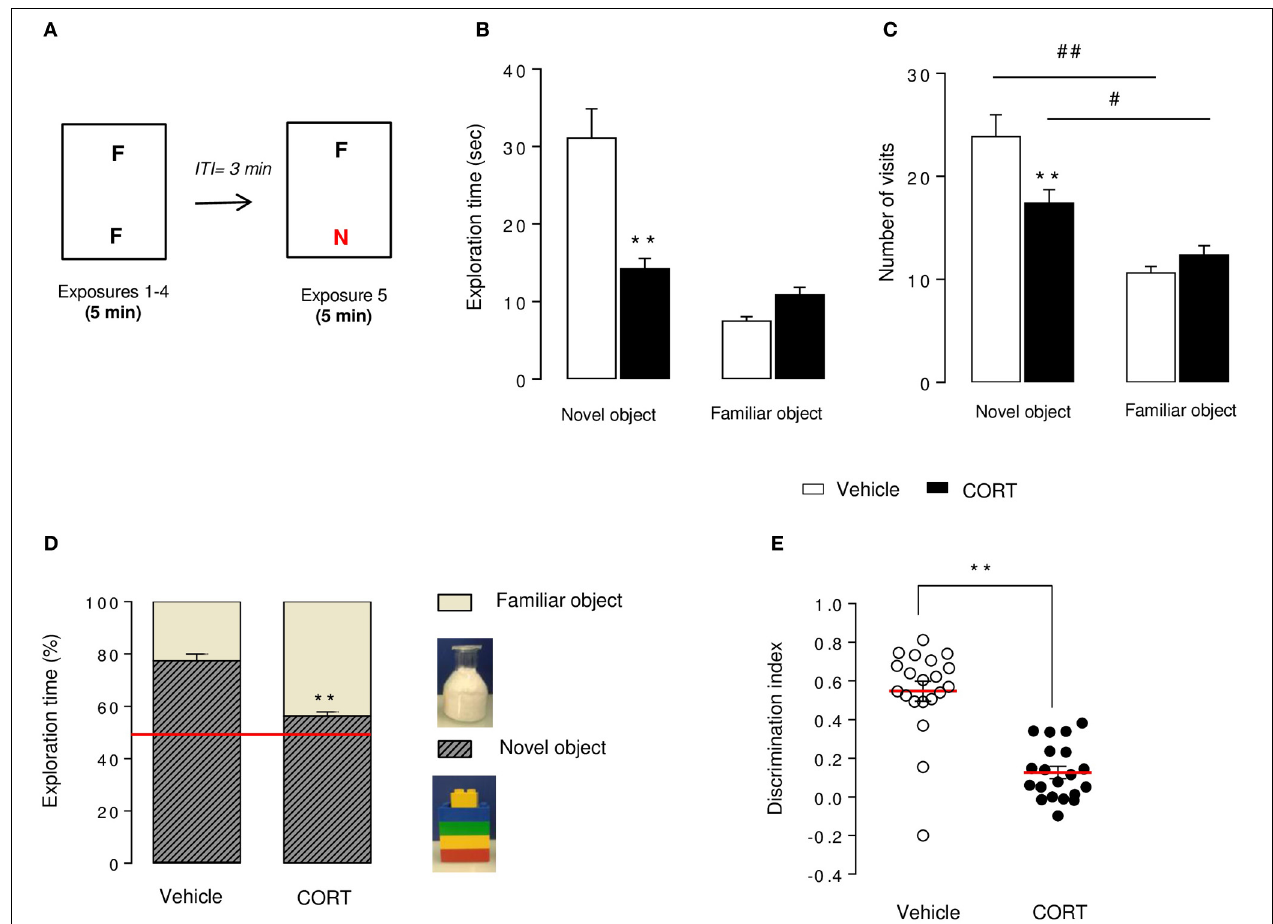
FIGURE 2 | Short-termepisodicmemoryisalteredinCORT-treatedmicein the novel object recognition test. Schematic diagram of the NORT experimental time course (A) . Mice were exposed to 2 identical objects during 4 sessions (5min each) with an intertrial interval (ITI) of 3min. During the 5thexposure, one familiar object (F) was removed and replaced with a novel object (N) different in shape, color, and texture. Exploration time (B) and